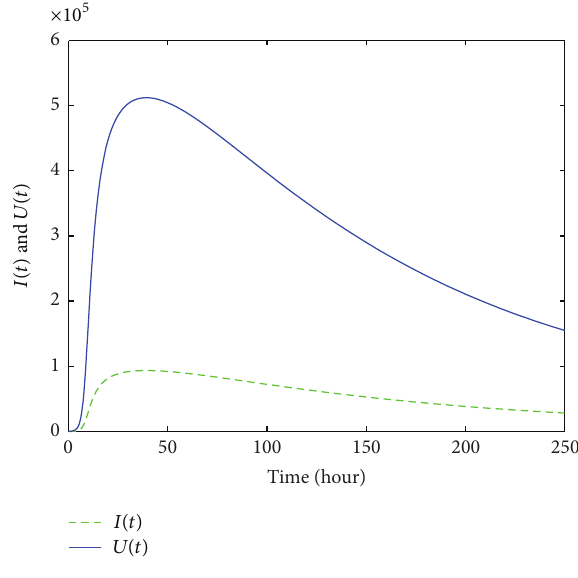
Figure 12: Mode one.